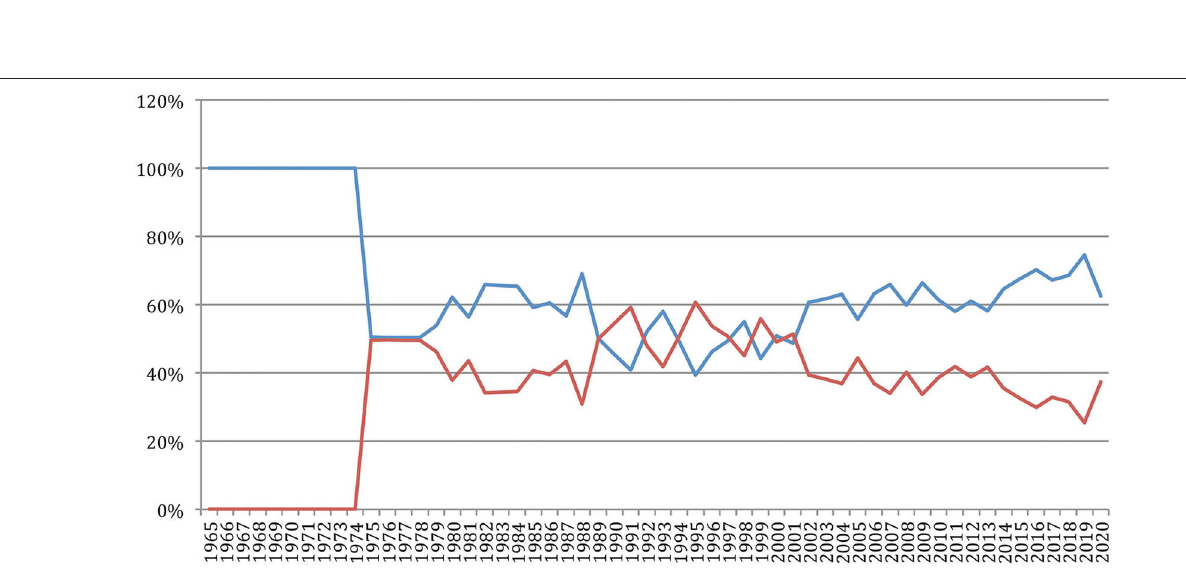
FIGURE 18 | Percentage of NLP (blue) vs. Speech (red) articles being cited over